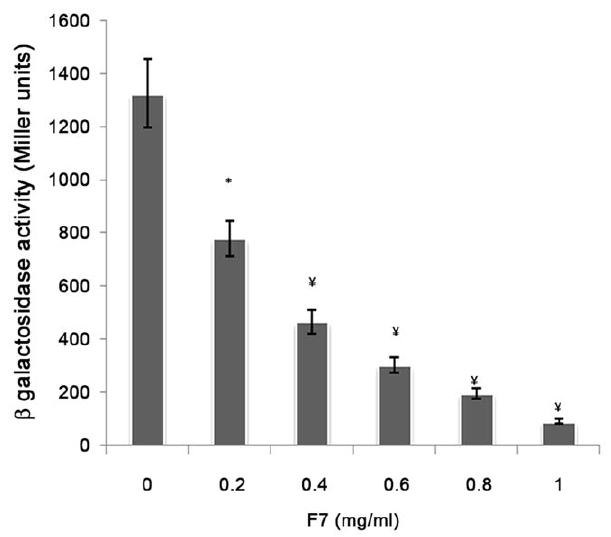
Figure 8. Antagonistic activity of F7 against 3-oxo-C 12 HSL mediated QS in E.coli bioreporter strain harboring pSC11(P la- sI ) ::lacZ ) and lasR expression vector pJN105L.